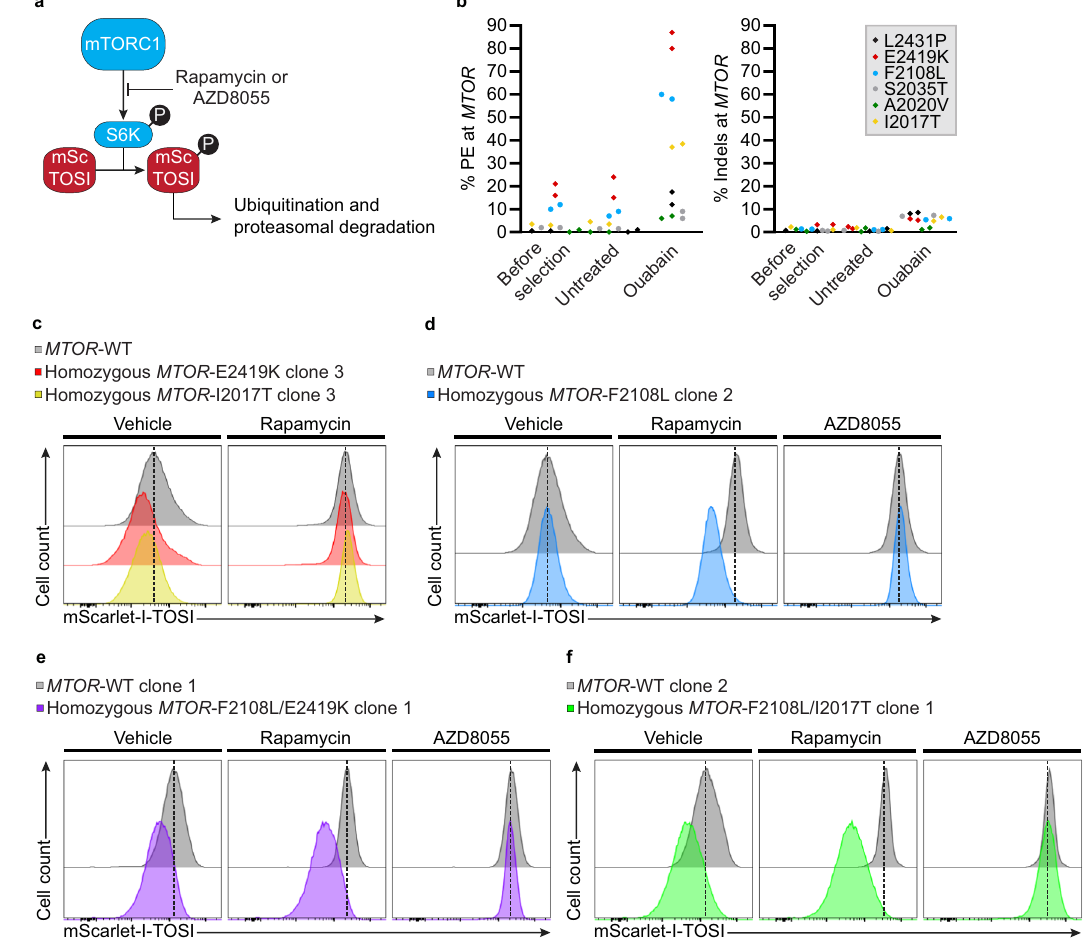
Fig. 3 | Co-selection for the installation of clinically relevant mutations at the MTOR locus. a Schematic of mScarlet-I mTOR Signaling Indicator (mSc-TOSI) reporterdegradationundermTORC1signaling. b PEandsmallindelsquanti fi cation asdeterminedbyBEATandTIDEanalysisfromSangersequencing.K562cellsstably expressing the mSc-TOSI reporter were transfected with PE3 vectors targeting ATP1A1 exon 4 (Q118R) and MTOR . Genomic DNA was harvested 3days post- transfection (before selection) and cells were treated (ouabain) or not (untreated) with100 µ Mouabainuntilallnon-resistantcellswereeliminated. n =2independent biological replicates performed at different times. c Histogram plot of mSc-TOSI intensity in homozygous single cell-derived K562 clones harboring MTOR